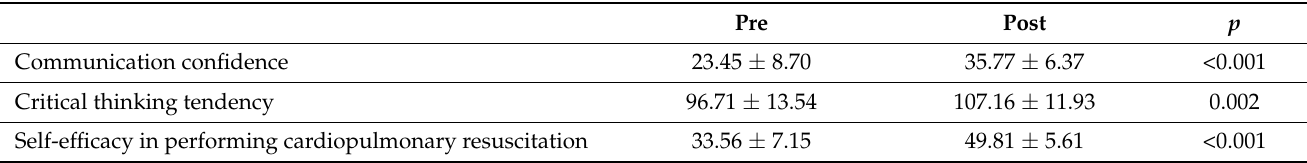
Table 4. Communication confidence, critical thinking tendency, and self-efficacy in cardiopulmonary resuscitation before and after Korean Advanced Life Support training ( n = 46).